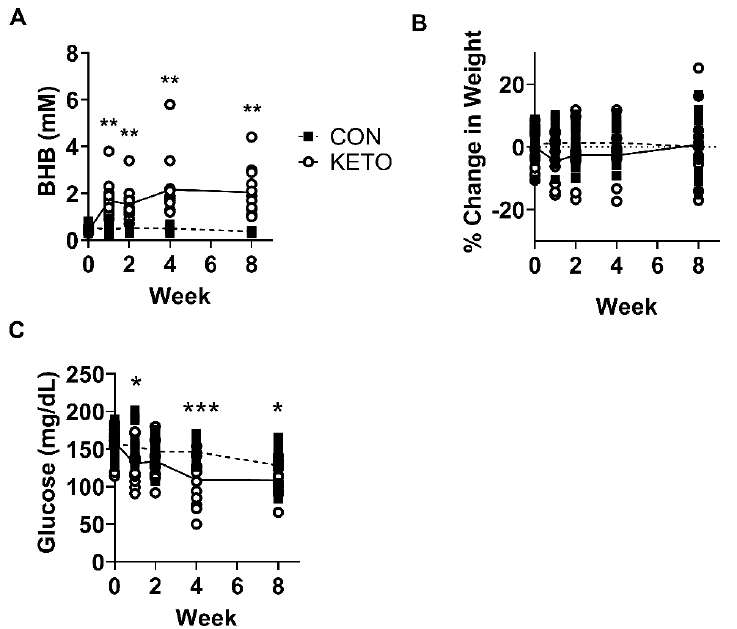
Figure 1. Ketogenic diet elevates blood ketone β -hydroxybutyrate (BHB). ( A ) Blood BHB (CON, n = 15; KETO, n = 14), ( B ) weight (CON, n = 15; KETO, n = 11), and ( C ) blood glucose (CON, n = 12;